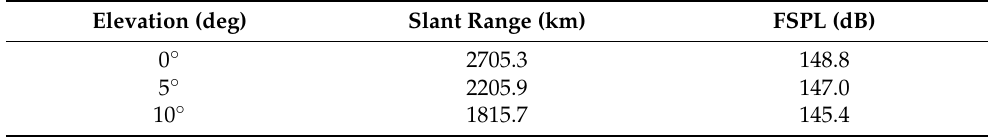
Table 3. Path loss calculation with the look angle and distance measured using Equations (11) and